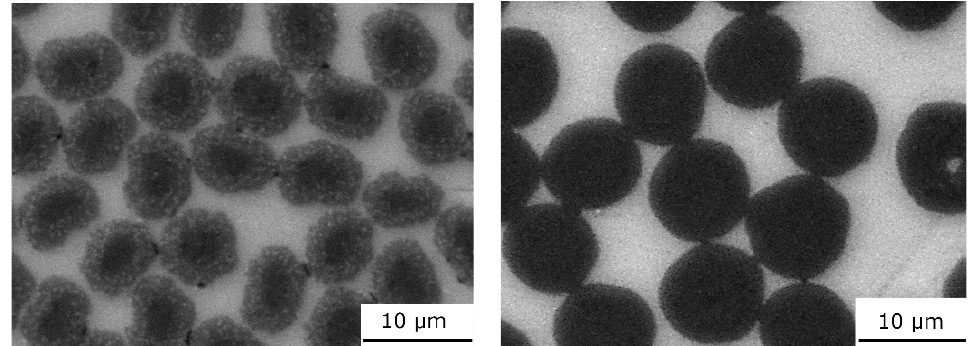
Figure 9. TEM image of the MgY/Granoc interface. 3.1.2. Structure of the Mg2Li/CF Composites Figure 10 shows microstructure Mg2Li/CF composites. Previous investigations [16,23] demonstrated that the EDX oxygen distribution on the fiber cross-section can be used as a rough indicator of the presence of Li 2 C 2 in carbon fibers. Lithium atoms penetrate inside carbon fibers and rapidly create Li 2 C 2 . Lithium carbide is formed inside fibers, and such reactive interfacial bonding does not appear in any interfacial products. Figure 11 shows strong and uniform Ok α signals within the whole-fiber cross-section. Previous results [16,23] showed that the infiltration parameters (temperature and time) and amount of alloying element influence the quality of the interfacial bonding and